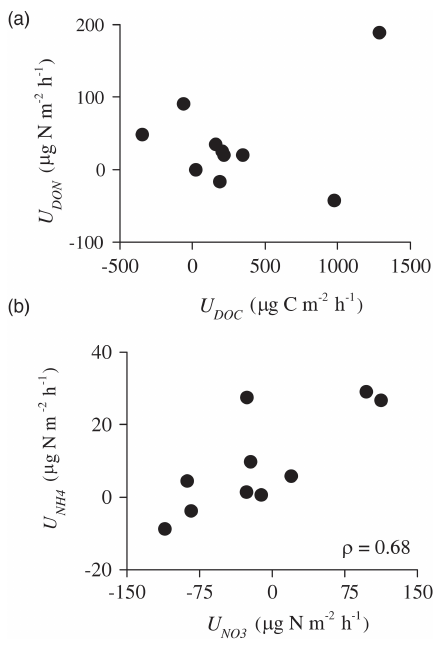
Figure 8. Relationship between in-stream net uptake along the study reach for (a) U DOC and U DON , and (b) U NO Spearman coefficient ( ρ ) is shown only when significant ( p